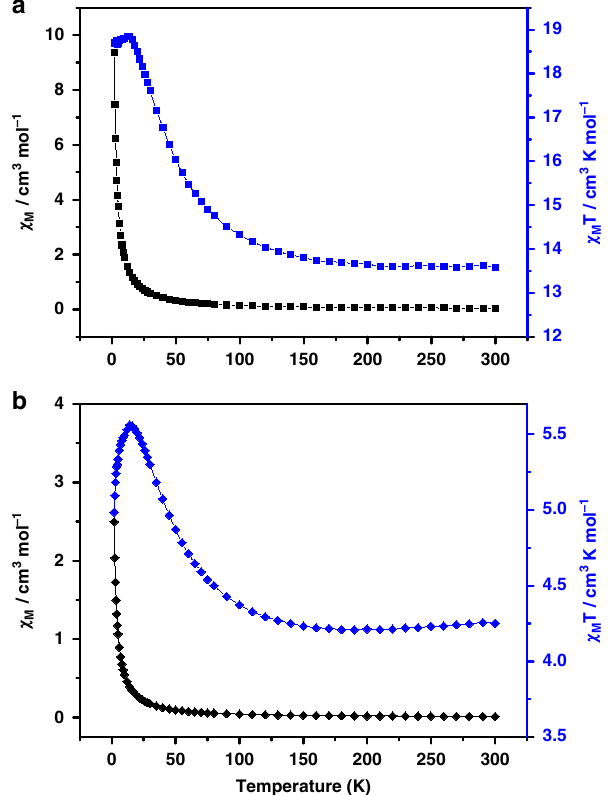
Fig. 6 Magnetic data for 1 and 1a. Temperature dependence of χ M and χ M T versus T plots for 1 ( a ) and 1a ( b